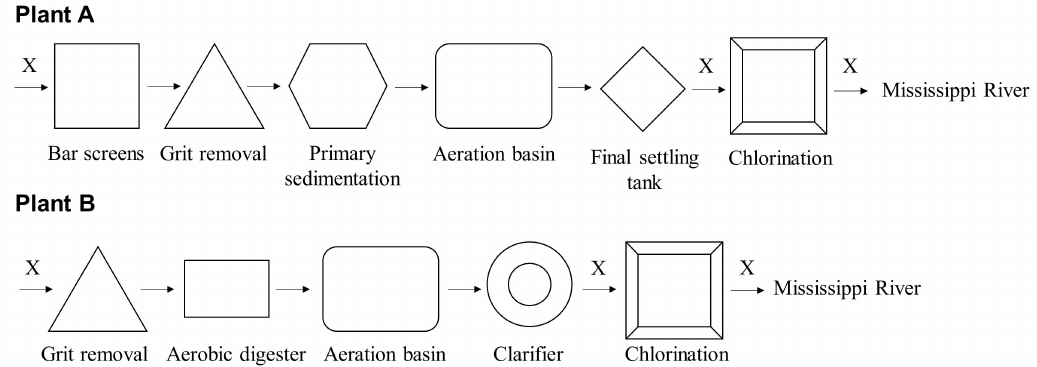
Figure 1. Schematic layout of the WWTPs. Letter “X” represents the sampling